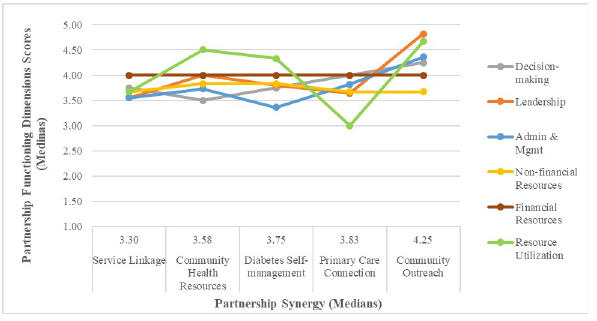
Fig 2. Partnership-level scores on dimensions of partnership functioning. Partnerships are ordered by increasing score on partnership synergy (and rank).